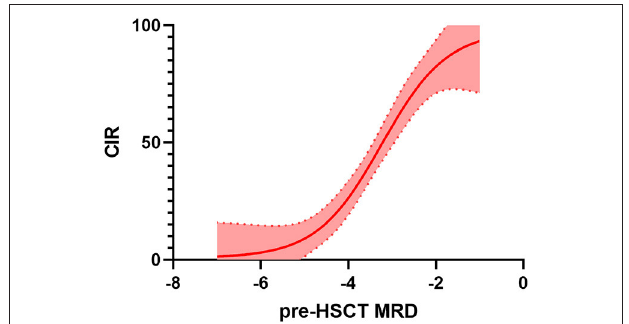
FIGURE 2 | Relationship between minimal residual disease (MRD) before haematopoietic stem cell transplantation (HSCT) and cumulative incidence of relapse (CIR). Several studies (differing in population characteristics, method of MRD detection, transplant platform, etc., see also Table 1 for details) have been pooled together and interpolation has been performed. Thus, this can not be considered a methodologically solid analysis but an illustrative example of the increasing risk of relapse related to increases in pre-HSCT